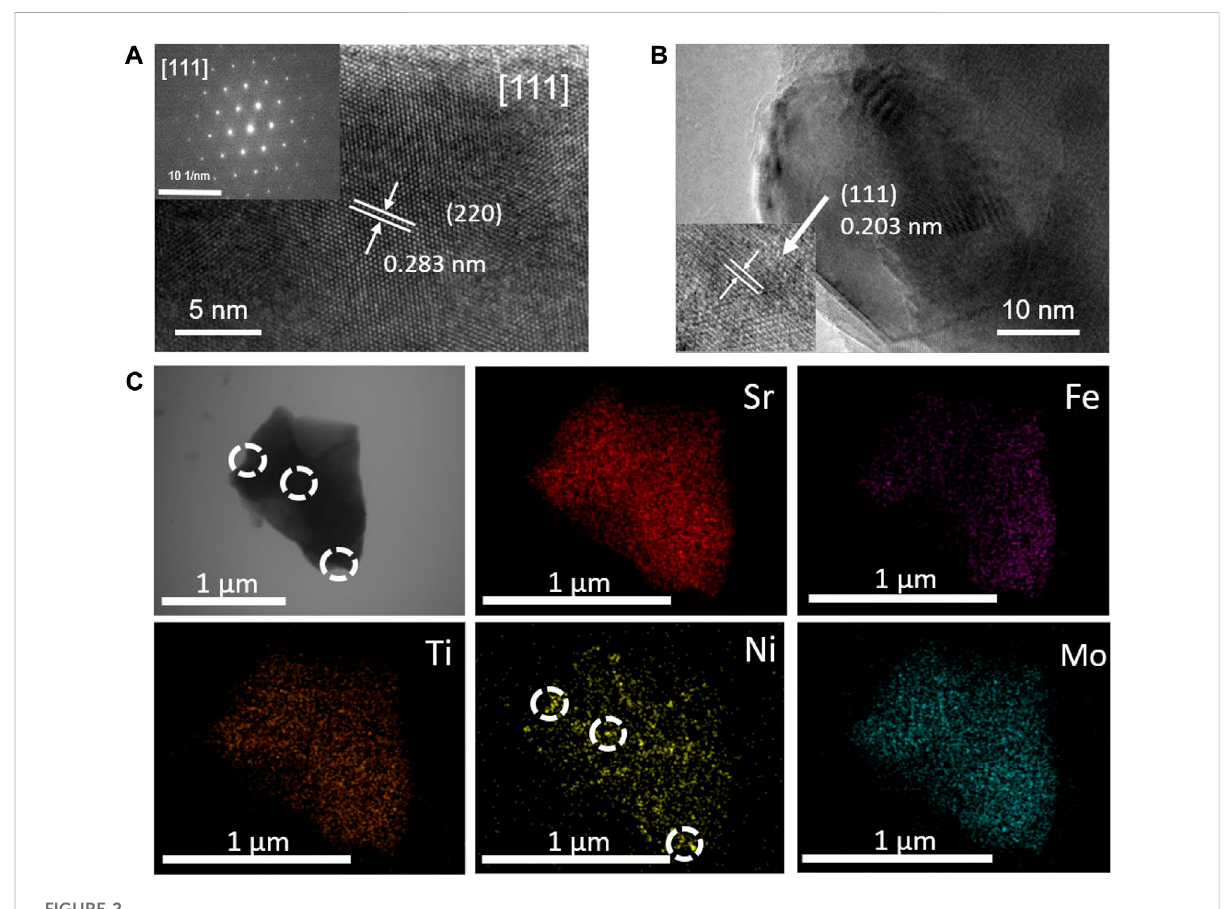
FIGURE 2 (A) HRTEM images and corresponding SEAD image patterns of SFNTM substrate; (B) HRTEM images of Ni nanoparticles; (C) STEM image